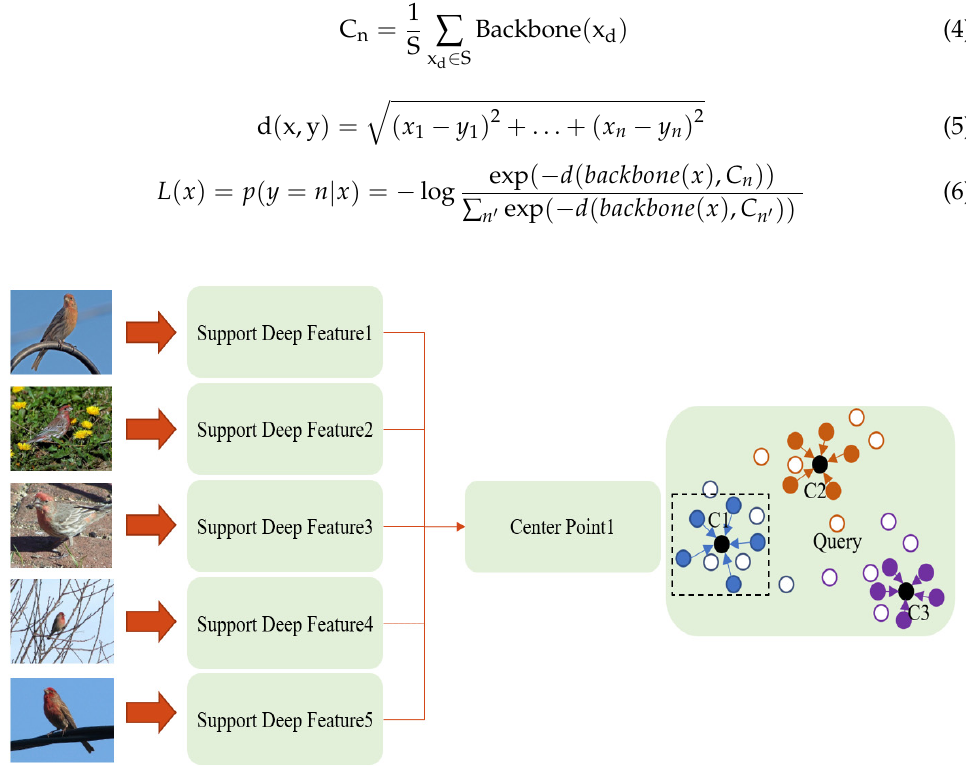
Figure 11. Support set deep feature extraction process.